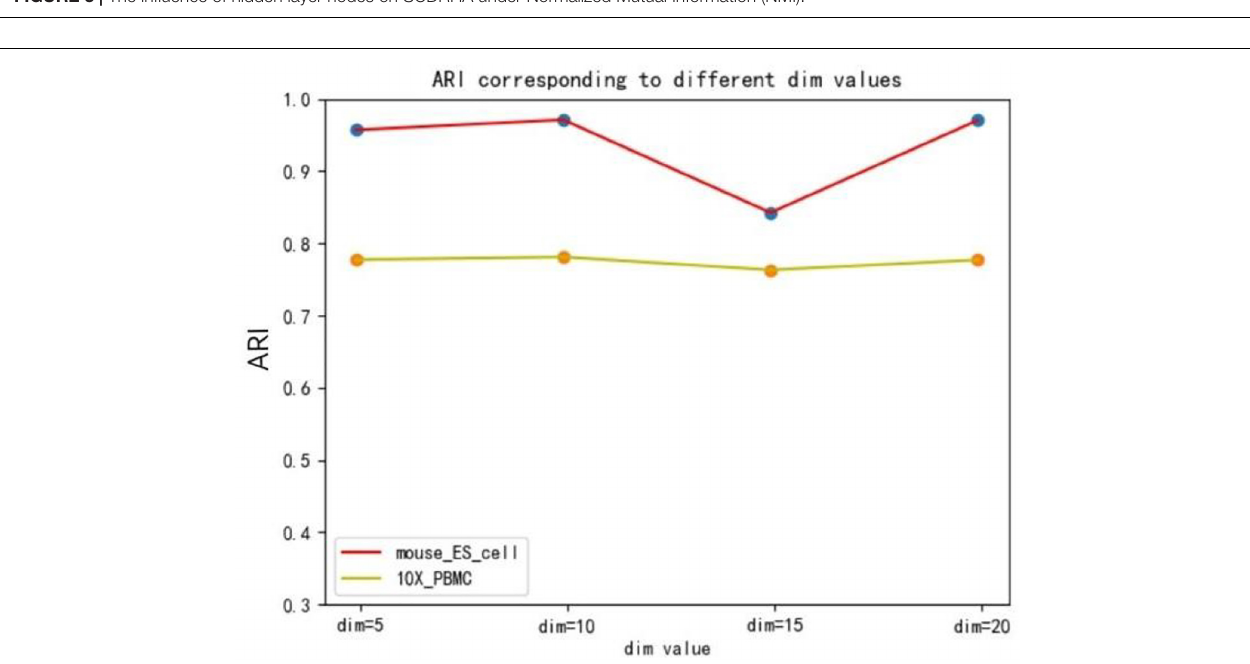
FIGURE 3 | The influence of hidden layer nodes on SCDRHA under Normalized Mutual Information (NMI).